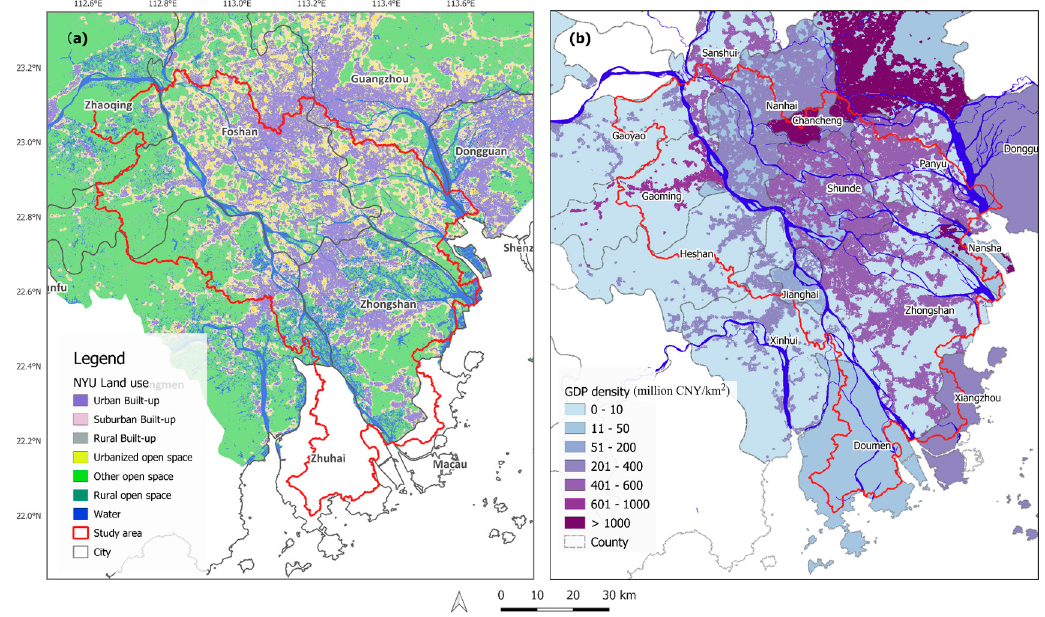
Figure 3. ( a ) Land categories inside the study area based on the 2014 dataset from the New York University (NYU) Urban Expansion Atlas, and ( b ) spatial distribution of GDP density in the study area.